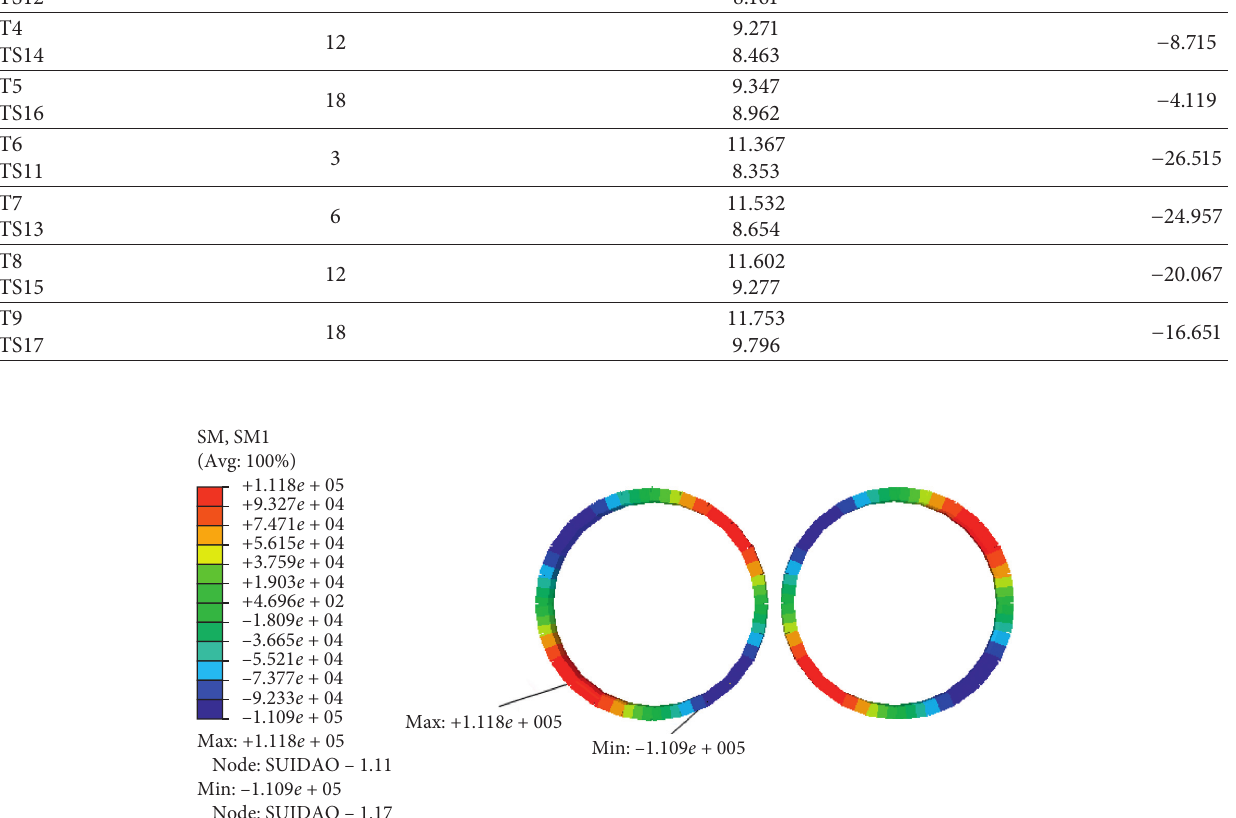
Figure 17: Bending moment cloud diagram of the tunnel